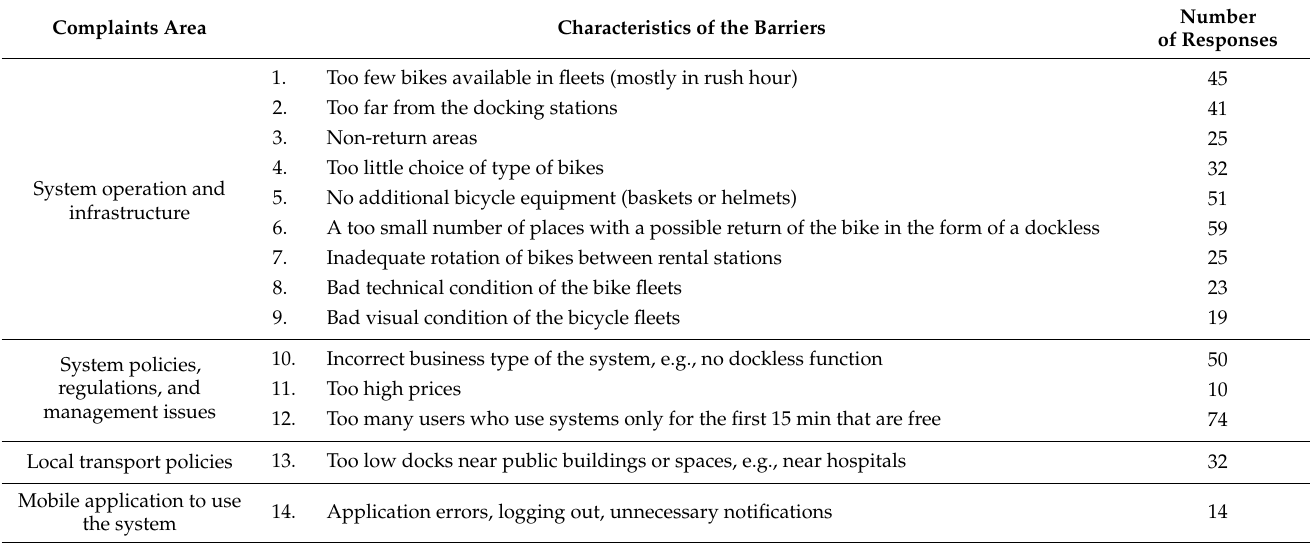
Table 4. Areas of complaints about bike-sharing systems.